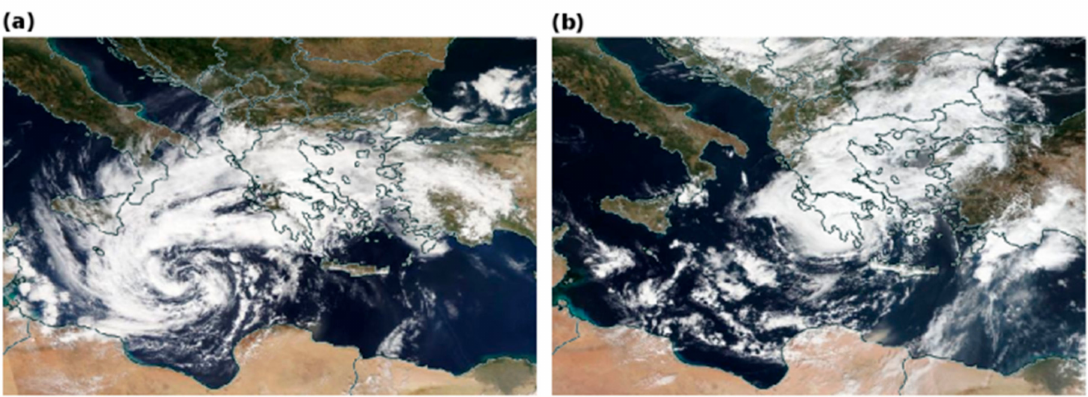
Figure 5. ( a ) MODIS / Aqua reflectance for 28 September 2018 and ( b ) VIIRS / NPP Suomi reflectance for 29 September